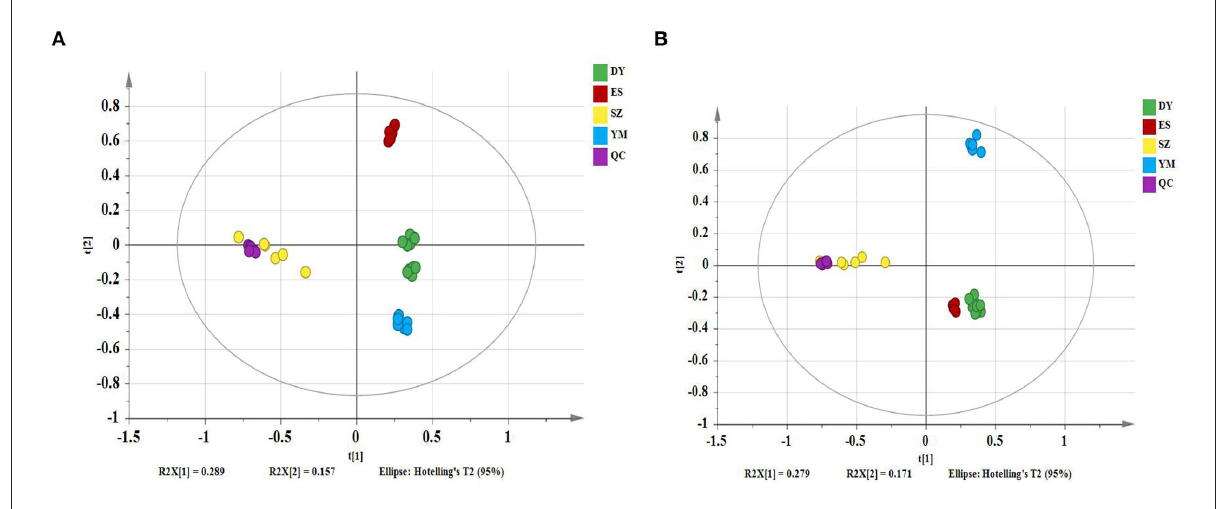
FIGURE1 The principal component analysis (PCA) scatter plot of different Oxytropis species [ (A) positive mode; (B) negative mode].